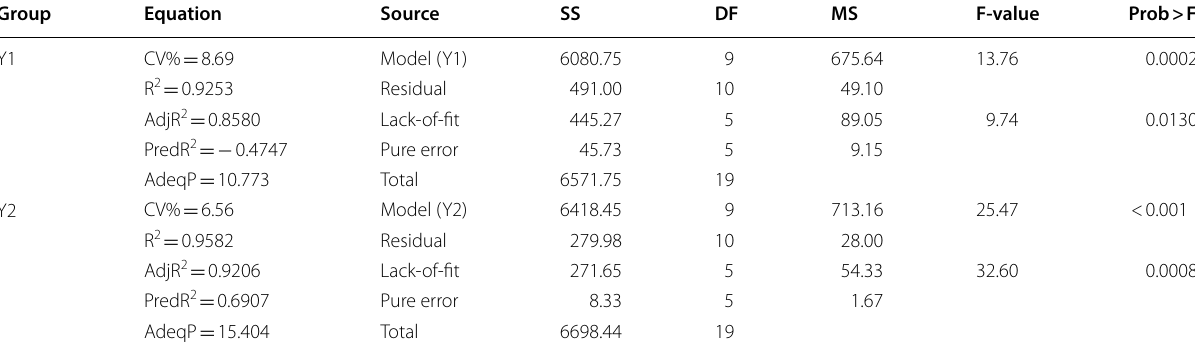
Table 3 ANOVA analysis of the predicted responses for quadratic polynomial models